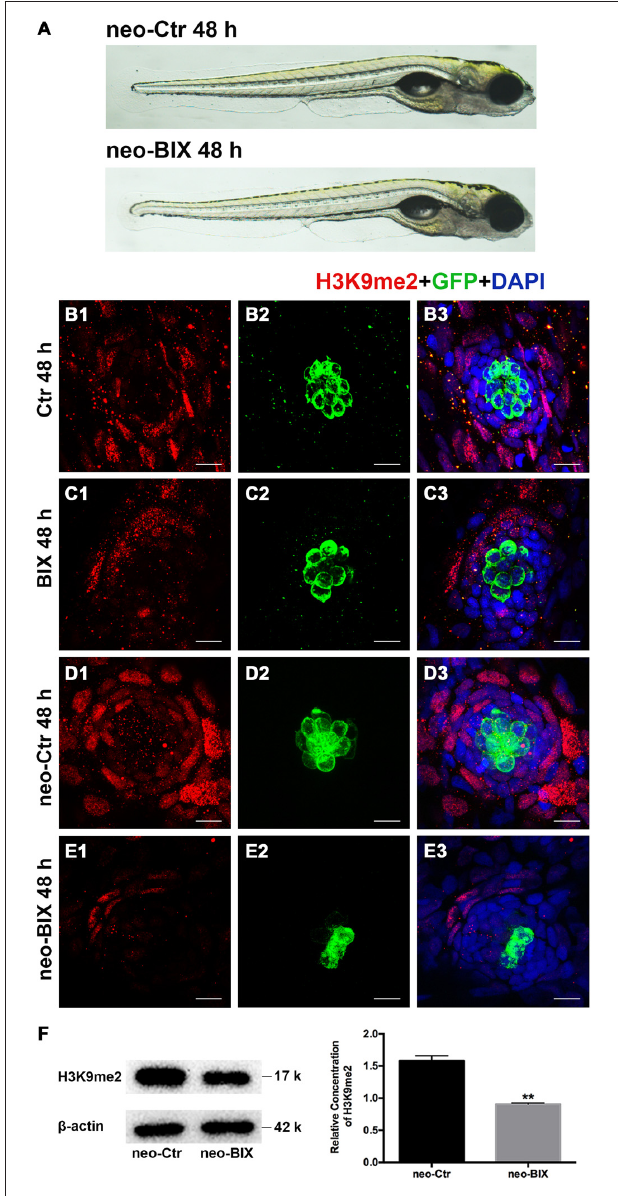
FIGURE 1 | BIX01294 treatment decreases H3K9me2 levels in zebrafish neuromasts (NMs). (A) Both the BIX01294 (BIX)-treated group and DMSO control group were morphologically normal following 1 h neomycin treatment. (B1,D1) H3K9me2 immunofluorescence (red) is of relatively high intensity in the control zebrafish NMs, and the H3K9me2 level increased at 48 h after neomycin damage for 1 h. (C1,E1) BIX01294 treatment reduced the H3K9me2 level, and the intensity of H3K9me2 was significantly decreased with the addition of 20 µ M BIX01294 for 48 h following 1 h neomycin damage. (B2–E3) Some degree of decreased hair cell (HC; green) regeneration after neomycin treatment for 1 h was also observed after exposure to BIX01294 for 48 h compared to the neomycin treatment controls, while a reduction in HCs was not obvious in the non-neomycin control groups. HCs were labeled with anti-GFP antibody (B2–C2) or green fluorescence (D2–E2) , and nuclei were labeled with 4,6-diamidino-2-phenylindole (DAPI; blue). Scale bar = 10 µ m. (F) The reduced H3K9me2 level by 20 µ M BIX01294 was reconfirmed with western blotting analysis at 48 h after neomycin damage. β -actin was included as the control. Mean ± SEM for three experimental replicates. ∗∗ p <